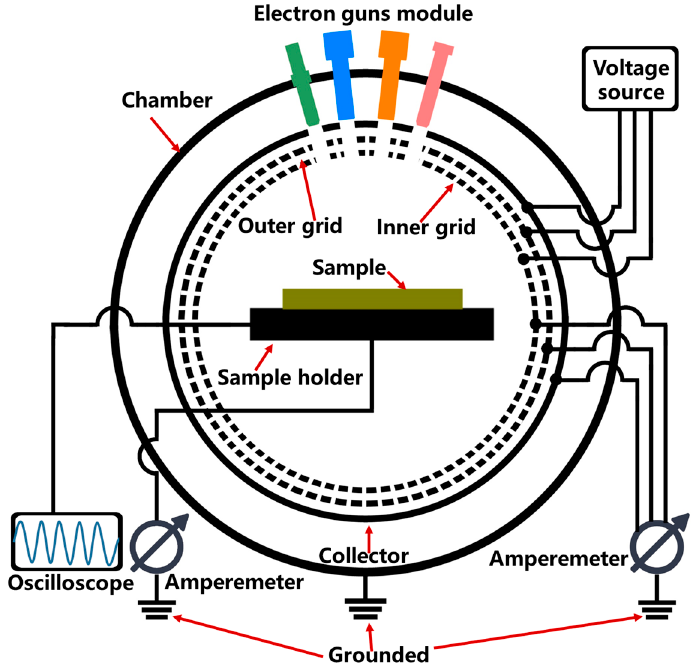
Figure 2. Inner structure of the SEY measurement facility.